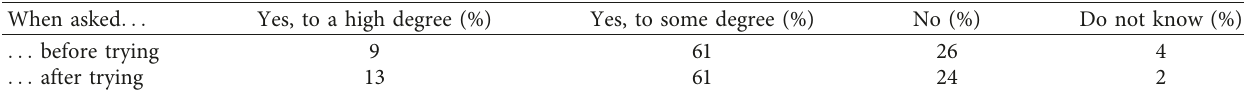
Table 4: Results from the question “Are you satisfied with your study technique?” posed to the students before and after they tried the new study skill(s). When asked . ..